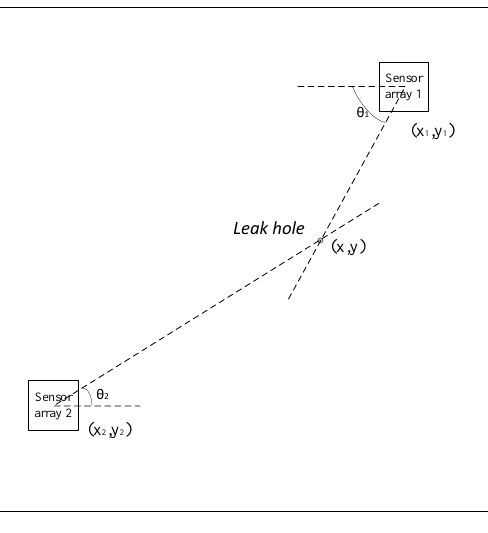
Figure 1. Locating principle